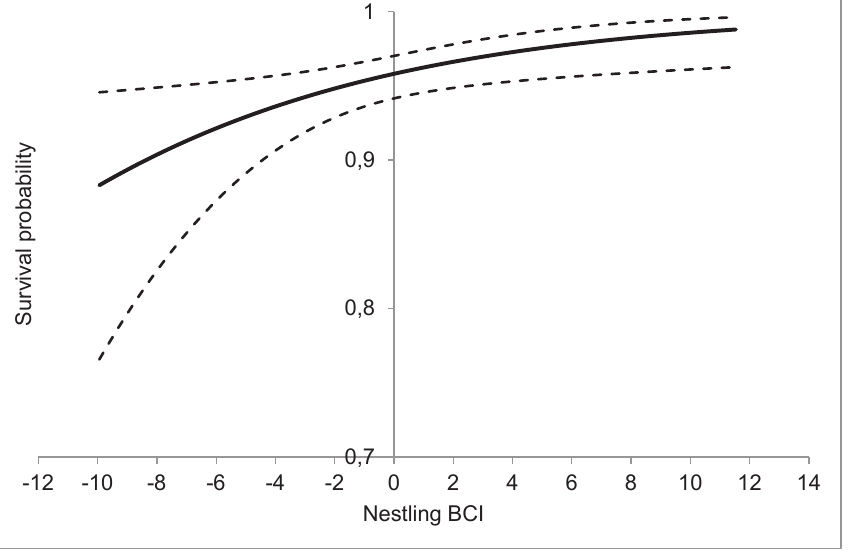
Figure 1. Predicted relationship between 4-day survival probability (solid line), ± 95% C.I. (dashed lines) and nestling body condition index (BCI) for ring ouzels in Glen Clunie during